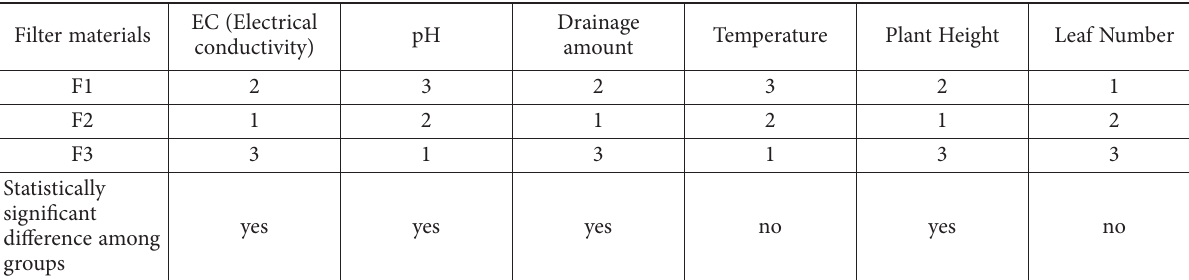
Statistically significant difference among